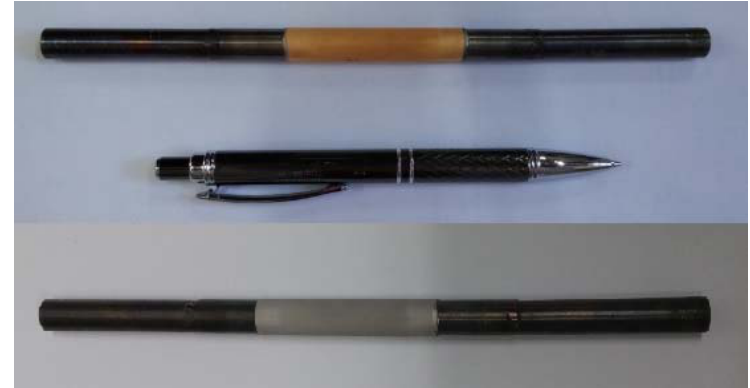
Figure 7. Picture of the supported Pd ‐ Au membrane before tests ( top ) and after ( bottom ).